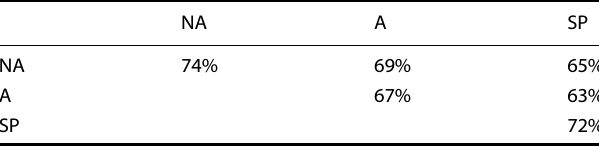
Table 1. Accordance of the occurrence of coded segments between different